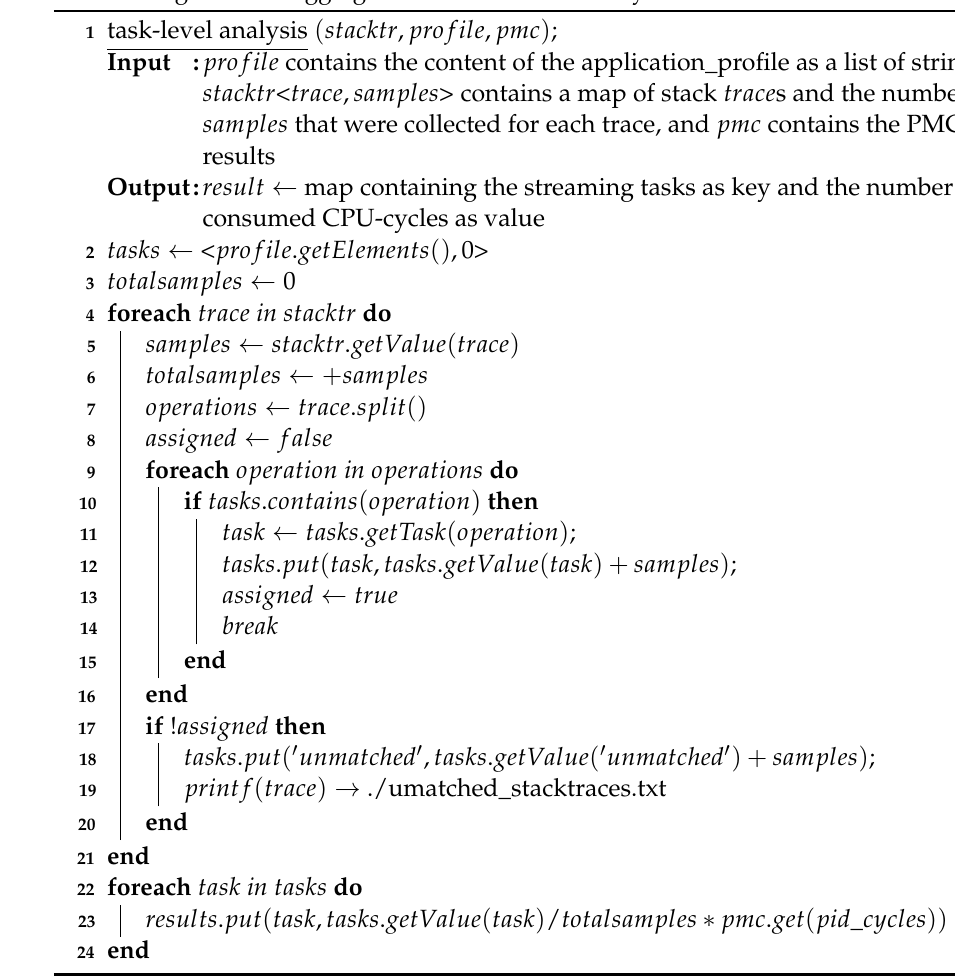
Algorithm 1: Stack trace analysis to identify the code paths associated with each streaming task and aggregate the number of CPU cycles consumed for each